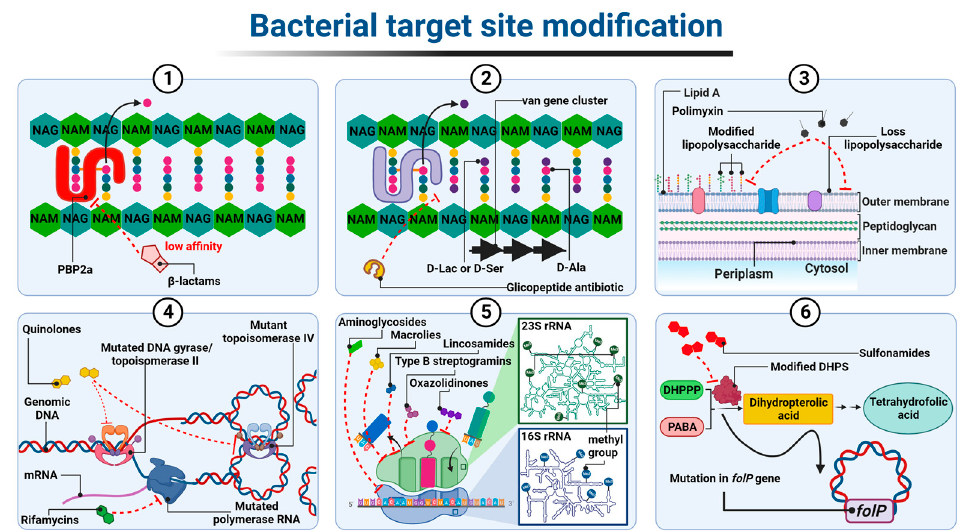
Figure 7. Diagrammatic illustration of some possible resistance mechanisms based on target site modification of antibiotics: ( 1 ) alteration in PBP; ( 2 ) altered cell wall precursors; ( 3 ) modified or loss of lipopolysaccharide; ( 4 ) mutated DNA gyrase/topoisomerase IV or RNA polymerase; ( 5 ) alteration in the 30S or 50S subunit; ( 6 ) modified DHPS. Figure created with Biorender.com.